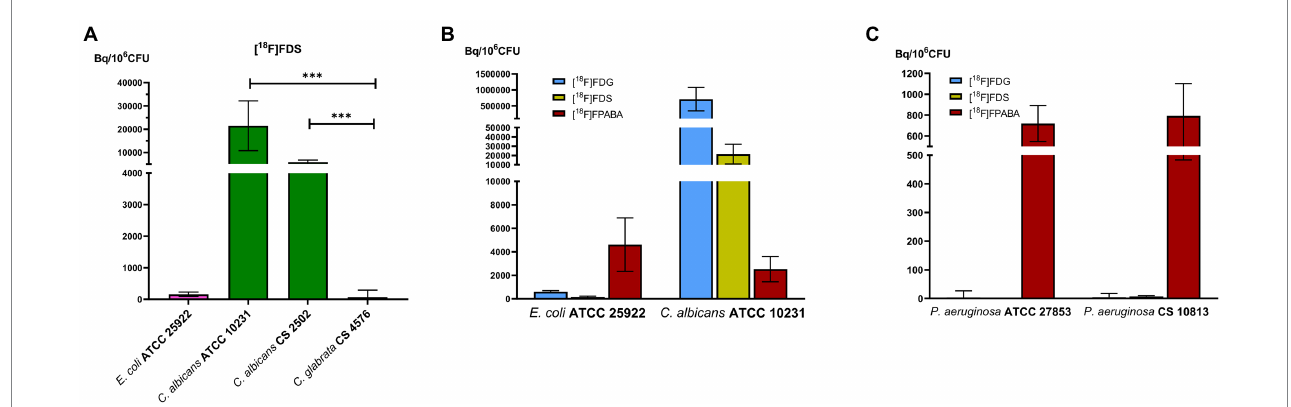
FIGURE 4 Comparison of prokaryotic and eukaryotic cells. In vitro experiments with Pseudomonas aeruginosa. (A) Comparison of [ 18 F]FDS uptake in Candida species. *** p ≤ 0.001; (B) Cellular uptake of reference strains of bacteria and yeast by [ 18 F]FDG, [ 18 F]FDS, and [ 18 F]FPABA; (C) P. aeruginosa uptake between [ 18 F]FDG, [ 18 F]FDS, and [ 18